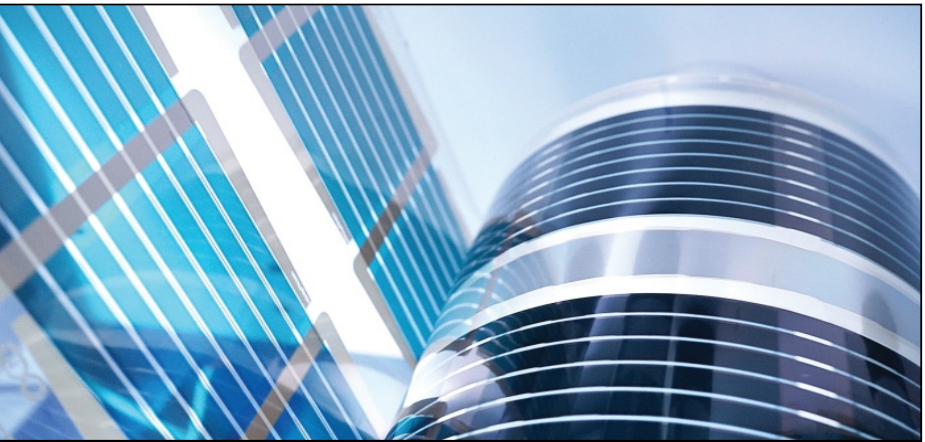
Figure 34. The capacity to produce the modules as big rolls of thin film using high-speed techniques is a main component of the low cost of developing photovoltaic devices.